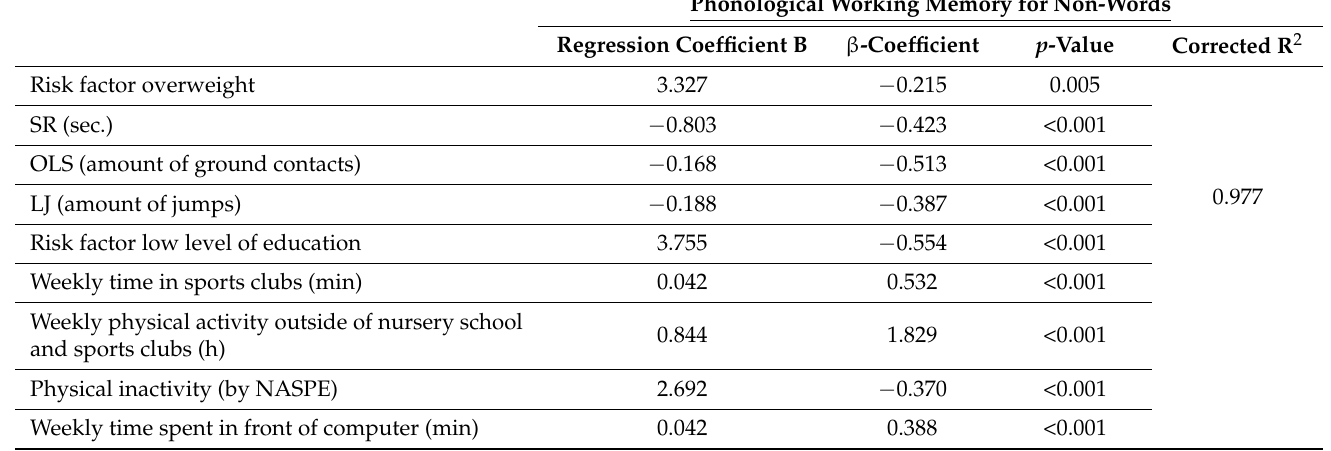
Table 7. Multiple linear regression analysis—End model of the subcategory ‘Phonological working memory for nonwords’. Phonological Working Memory for Non-Words Regression Coefficient